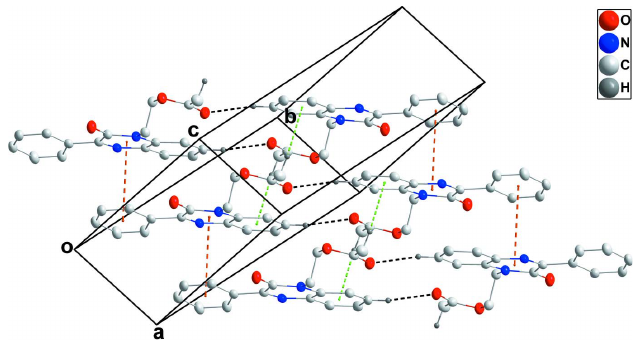
Figure 2 Perspective view of the packing. Intermolecular C—H (cid:2)(cid:2)(cid:2) O hydrogen bonds are shown by black dashed lines while (cid:2) -stacking and C— H (cid:2)(cid:2)(cid:2) (cid:2) (ring) interactions are shown, respectively, by orange and green dashed lines.